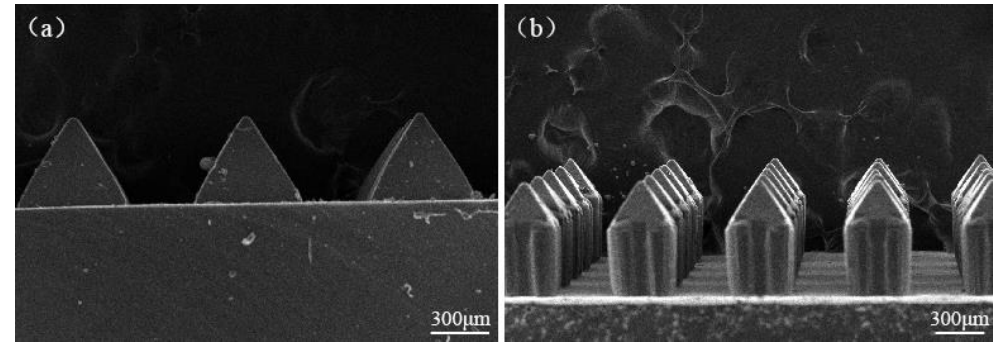
Figure 10. The SEM image of ( a ) MNA tip part and ( b ) the whole MNA.